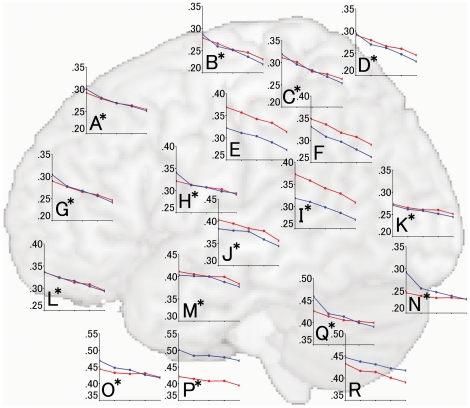
Correlations between age group and regional gray matter volumes in the superior frontal gyrus (A), precentral gyrus (B), superior parietal lobule (C), postcentral gyrus (D), supramarginal gyrus (E), inferior parietal lobule (F), middle frontal gyrus (G), paracentral lobule (H), angular gyrus (I), superior temporal gyrus (J), middle occipital gyrus (K), inferior frontal gyrus (L), middle temporal gyrus (M), inferior occipital gyrus (N), left inferior temporal gyrus (O), right inferior temporal gyrus (P), anterior lobe of the cerebellum (Q), and posterior lobe of the cerebellum (R).Graphs of both the left and right hemispheres of the inferior temporal gyrus are shown because of the age × gender × hemisphere interaction in the region. In each graph, the vertical axis indicates regional gray matter volume (no units), and the horizontal axis refers to subjects in the third (aged 20–29), fourth (aged 30–39), fifth (aged 40–49), sixth (aged 50–59), and seventh (aged 60–69) decades of life, respectively, moving from left to right. Blue and red lines indicate data obtained from men and women, respectively. To facilitate comparisons of the rate of gray matter volume decline in each region, the range of the vertical axis was set at 0.15, with the exception of the left and right inferior temporal gyri (in which the range was set at 0.20). Each graph is superimposed onto a brain MR image of the lateral view that nearly corresponds to the anatomical location. Asterisk in each graph indicates a region that shows significant age by gender interactions.